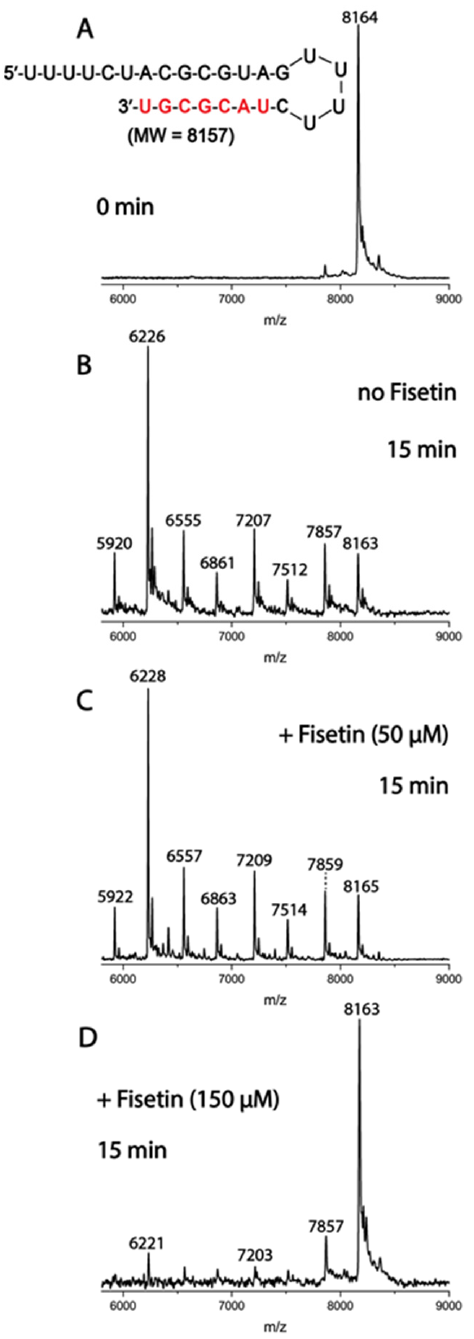
Figure 6. Inhibition of SARS-CoV-2 ExoN activity by fisetin. A mixture of 500 nM RNA (sequence shown at the top of the figure) and 50 nM SARS-CoV-2 pre-assembled exonuclease complex (nsp14/nsp10) was incubated in buffer solution at 37 ◦ C for 15 min ( B ) in the absence and ( C , D ) presence of 50 µ M and 150 µ M fisetin. The ( A ) RNA and the ( B – D ) products of the ExoN reaction were analyzed by MALDI-TOF MS. The signal intensity was normalized to the highest peak. The peak at 8164 Da corresponds to the intact RNA (8157 Da expected).